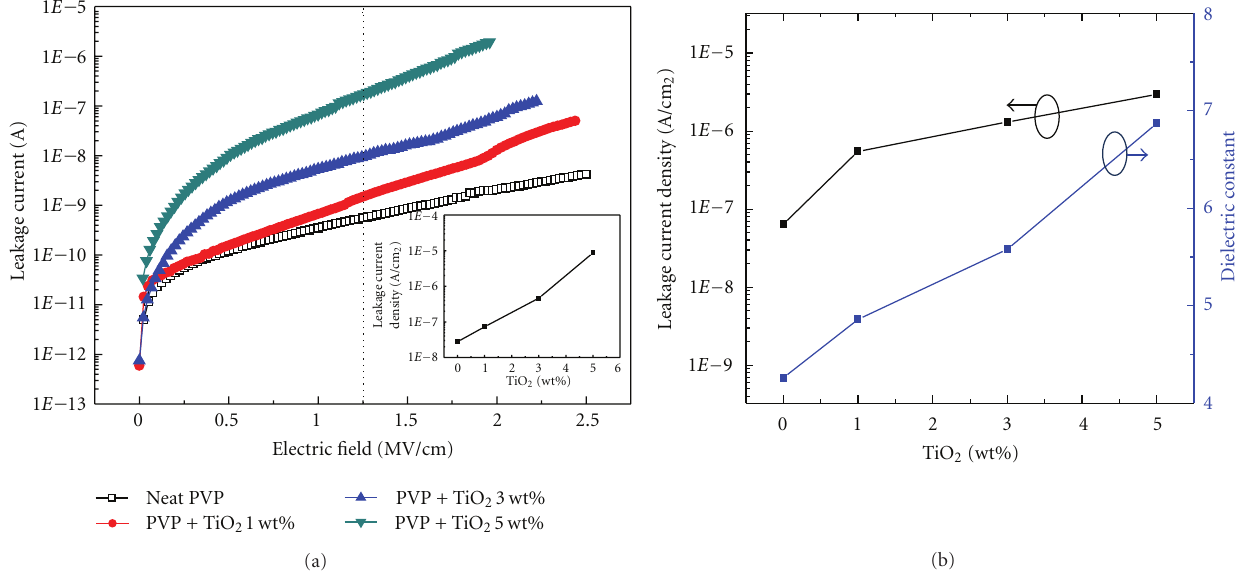
Figure 2: The plots of (a) I - V characteristics and (b) relation of leakage current and surface roughness to TiO 2 ratio in the MIM structure using nanocomposite insulators with various TiO 2 concentration.